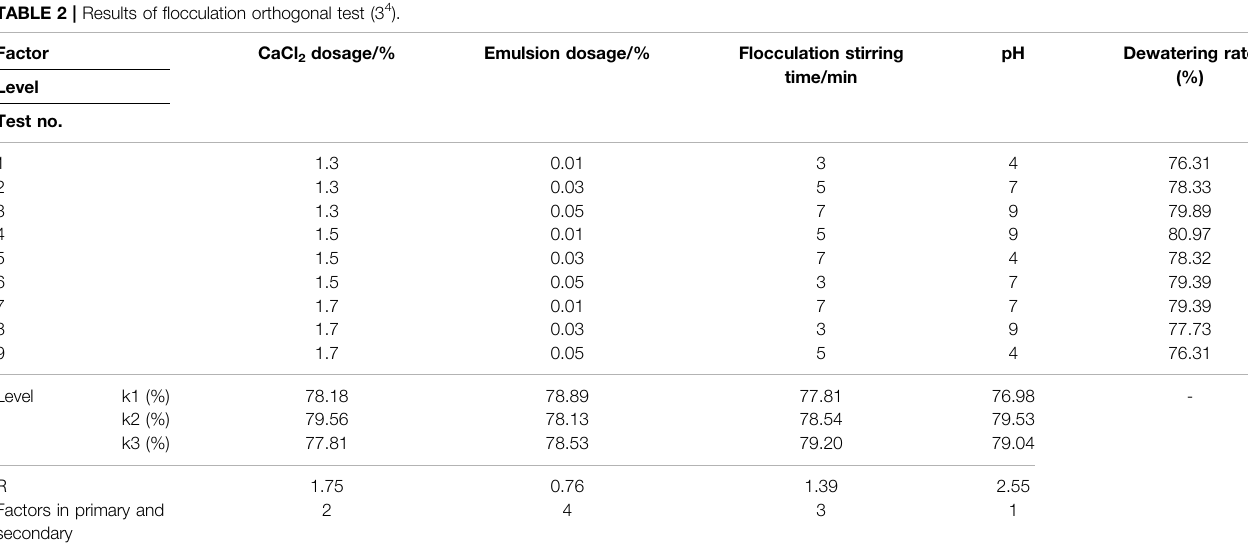
TABLE 2 | Results of fl occulation orthogonal test (3 4 ).